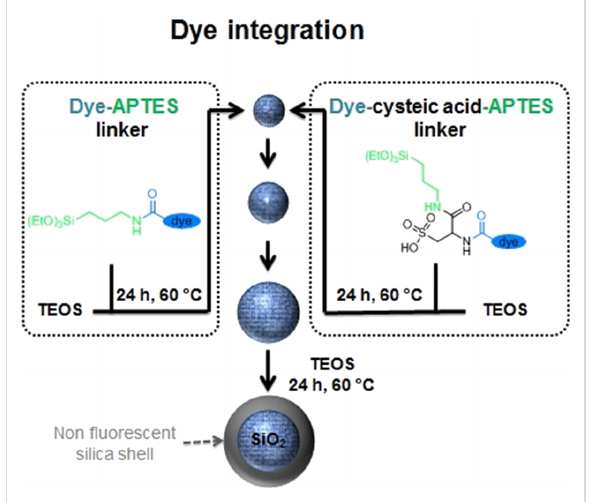
Figure 2: Schematic synthetic procedures for the multistep prepara- tion of dye-conjugated silica nanoparticles in the size range between 15 and 80 nm. All particle growth steps were conducted via L-arginine- catalysed hydrolysis of TEOS in a biphasic water–cyclohexane system at 60 °C. Dye embedding was achieved during particle (re)growth by addition of modified dye. Dyomics dyes and the dye Star635 could be directly incorporated into the particle matrix if coupled to APTES. For the dye Atto647N, the introduction of a negatively charged cysteic acid group is required to yield well-defined fluorescent probes. If necessary the obtained silica nanoparticles can be further covered by a pure silica layer through repeating the shell growth step without embedding of fluorescent